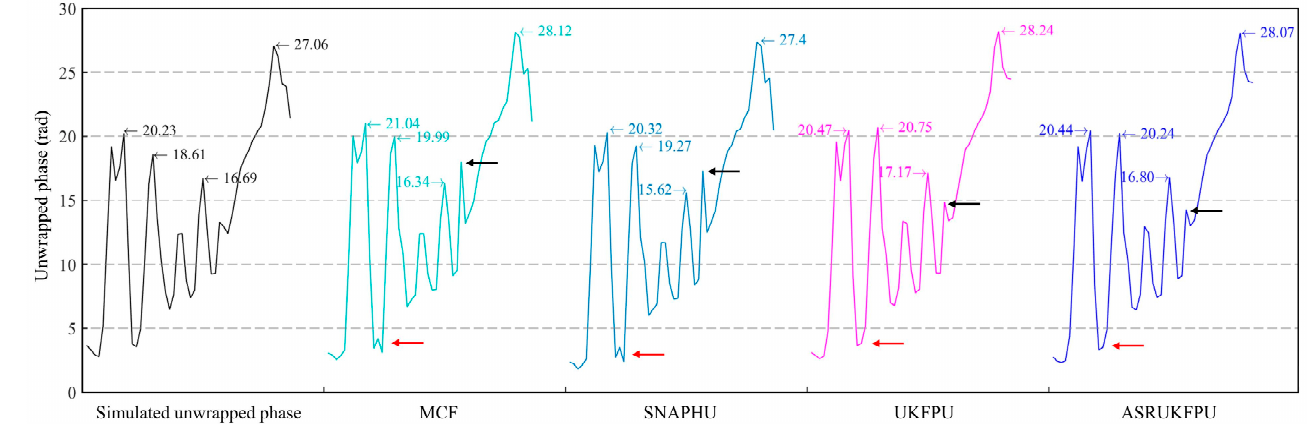
Figure 12. The PU results of a line of the pixels in the actual interferogram.